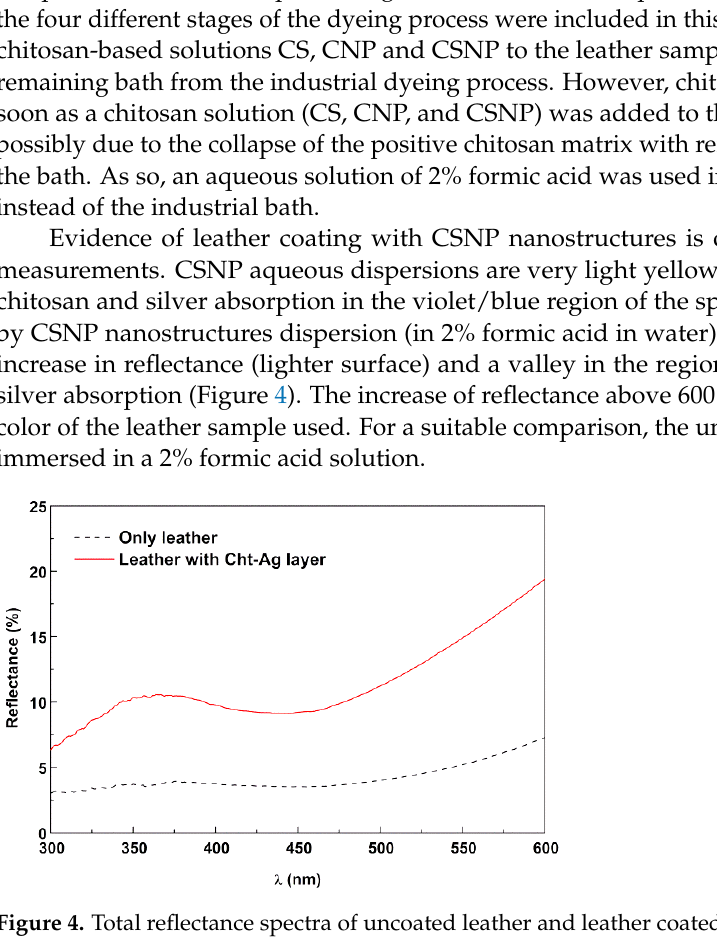
Figure 3. ( A ). Hydrodynamic diameter and zeta-potential values of chitosan nanostructures, at dif- ferent pH values. Inset: Polydispersity index. ( B ) . Zeta-potential values of chitosan/silver nanocom-